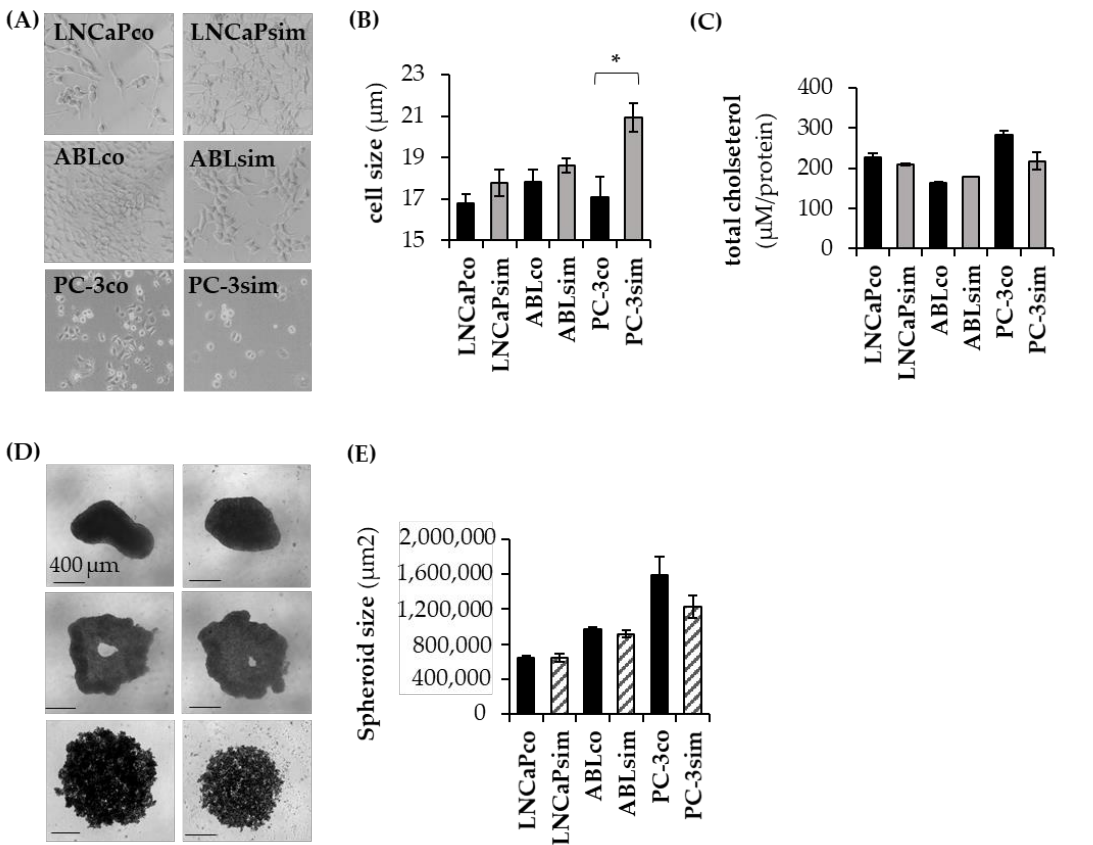
Figure 3. Morphological changes following long-term simvastatin treatment. ( A ) Representative images were taken from each cell line. Magnification 100×. ( B ) Cell size was determined with a Casy cell counter and analyzer. ( C ) Cholesterol levels were determined with a bioluminescent assay as described under material and methods. Total cholesterol levels were normalized to protein content that was determined via BCA assay. ( D,E ) Cells were seeded into Corning 7007 96-well plates to form 3-dimensional spheroids. After 8 days of culture, spheroid size was determined with an image- based brightfield IncuCyte ® S3 LiveCell Analysis System. Data are represented as mean ± SEM. (* p < 0.05). As shown in Figure 4, the long-term simvastatin-treated cell lines were resistant to the growth-inhibitory effect of simvastatin and atorvastatin compared to their respective parental cells (Figure 4). Of note, however, LNCaPsim cells seemed to become more sensitive to the anti-androgens enzalutamide, apalutamide and abiraterone (Figure 4A). ABLsim, on the other hand, were not inhibited by the anti-androgens, though also not stimulated, a phenomenon that was observed in ABLco cells (Figure 4B). All three long- term simvastatin-treated cell lines still responded to treatment with the chemotherapeutic drugs docetaxel and cabazitaxel, although PC-3sim cells seemed to be less sensitive compared to PC-3co cells (Figure 4C). In castration-resistant ABLsim, by contrast, the effect of docetaxel and cabazitaxel was even stronger than in ABLco cells.